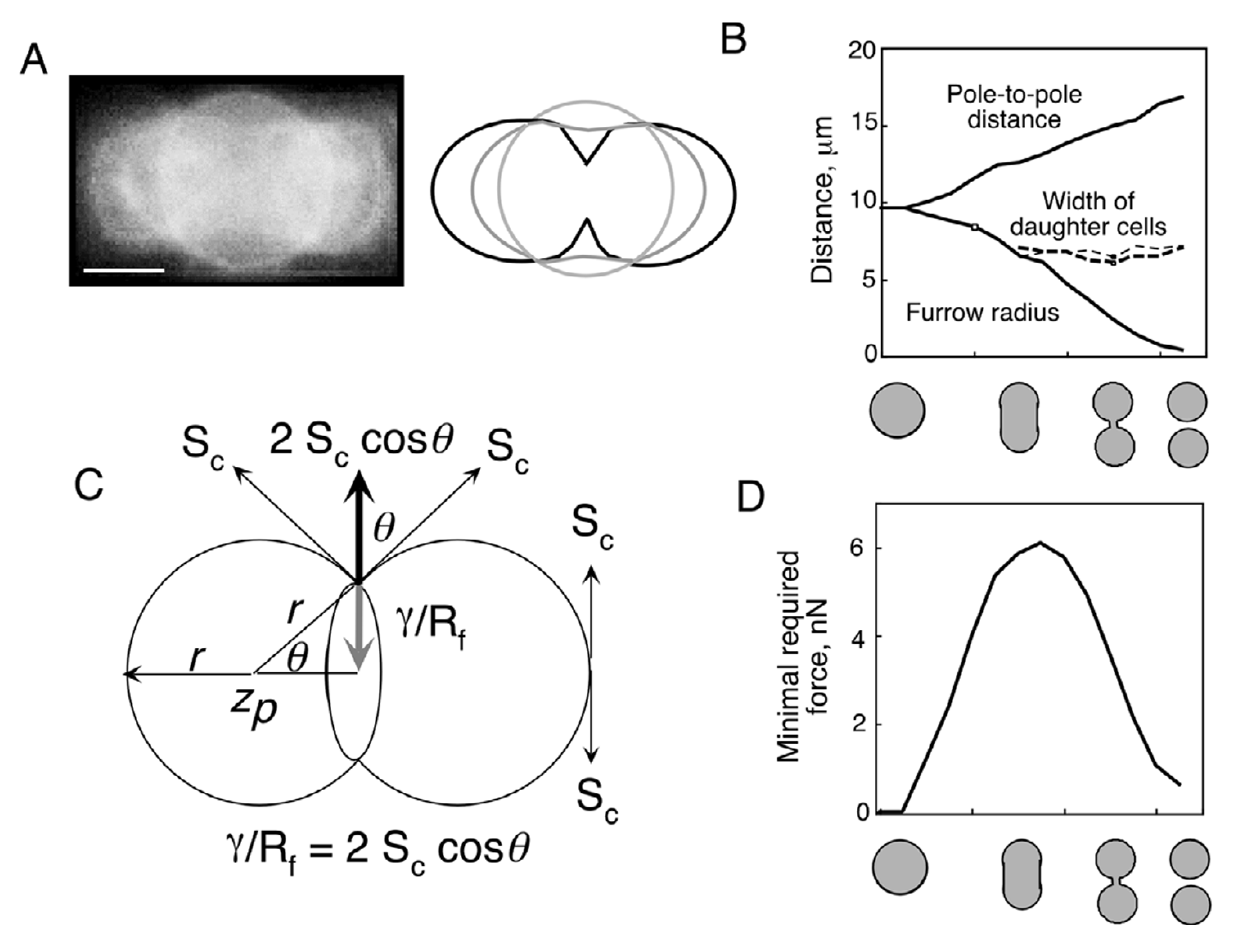
Figure 4 A. An overlay of micrographs of sequential stages of a dividing D. discoideum cell expressing GFP-dynacortin [30]. Stationary rings are apparent. The cartoon highlights the shape of the cell cortex during the sequential shape changes. Bar, 5 µ m. B. The pole-to-pole distance increases as the cleavage furrow radius decreases. As soon as the emerging daughter cells become distin- guishable, their cross-sectional diameters remain constant until the completion of division. C. The vectors that were calculated to relate the contractile force to the cortical stiffness. The radius of the furrow is also the radius of curvature of the ingressing furrow cortex and γ is the minimal required contractile force if the cortical stiffness is S c . D. The minimal estimated force required at any point of division is plotted as a function of cell